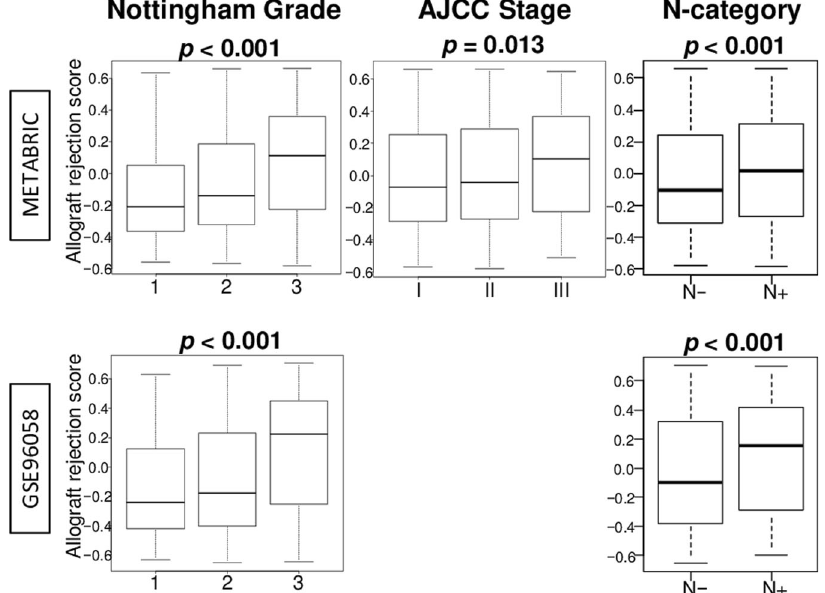
Fig. 4 Breast cancer with a high allograft rejection score was signi fi cantly associated with aggressive pathological grade, advanced stage, and lymph node metastasis. Boxplots of the score by Nottingham pathological grade, American joint cancer commit (AJCC) stage, and lymph node metastasis status in the METABRIC and GSE96058 cohorts. p -values were calculated by Kruskal – Wallis and Mann – Whitney U test. Boxplots were of Tukey type, with boxes depicting median and inter-quartile